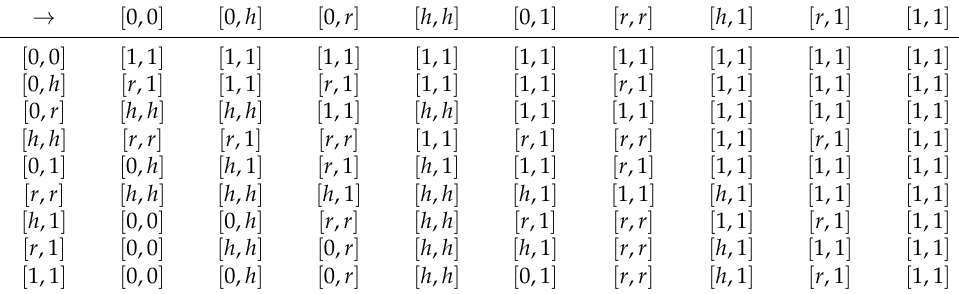
Table 2. The operator → of algebra in Example 5.